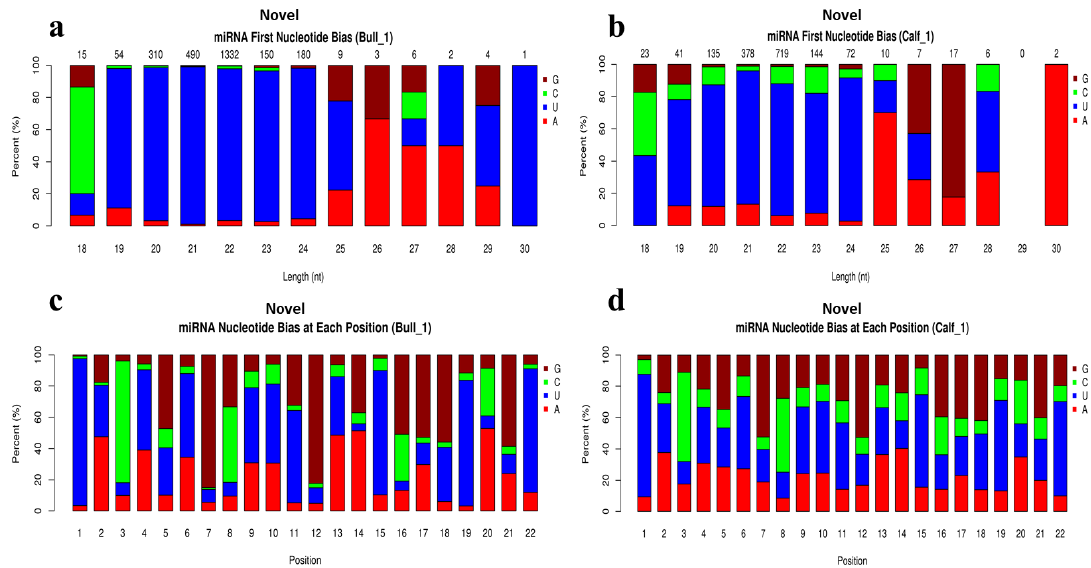
Figure 4. Novel miRNAs first nucleotide bias and bias at each position were investigated in bull and calf testes. ( a ) The X-axis represents the length of novel miRNAs and Y-axis shows the percent ratio of G/C/U and A bases. The ( b ) showed the analysis of first base preference in calf testes sample. ( c ) Exhibits the nucleotide bias at each position in bull testes. ( d ) The abscissa of the findings shows position of nucleotide in novel miRNAs; and ordinate shows the responding percentages ratio of G/C/U/A bases for each nucleotide in calf.